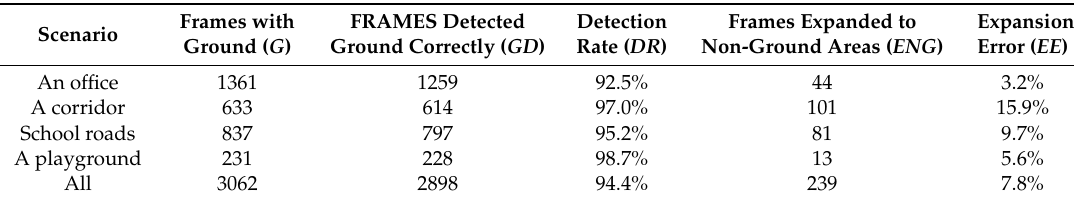
Table 1. Detection rate and expansion error of the approach.